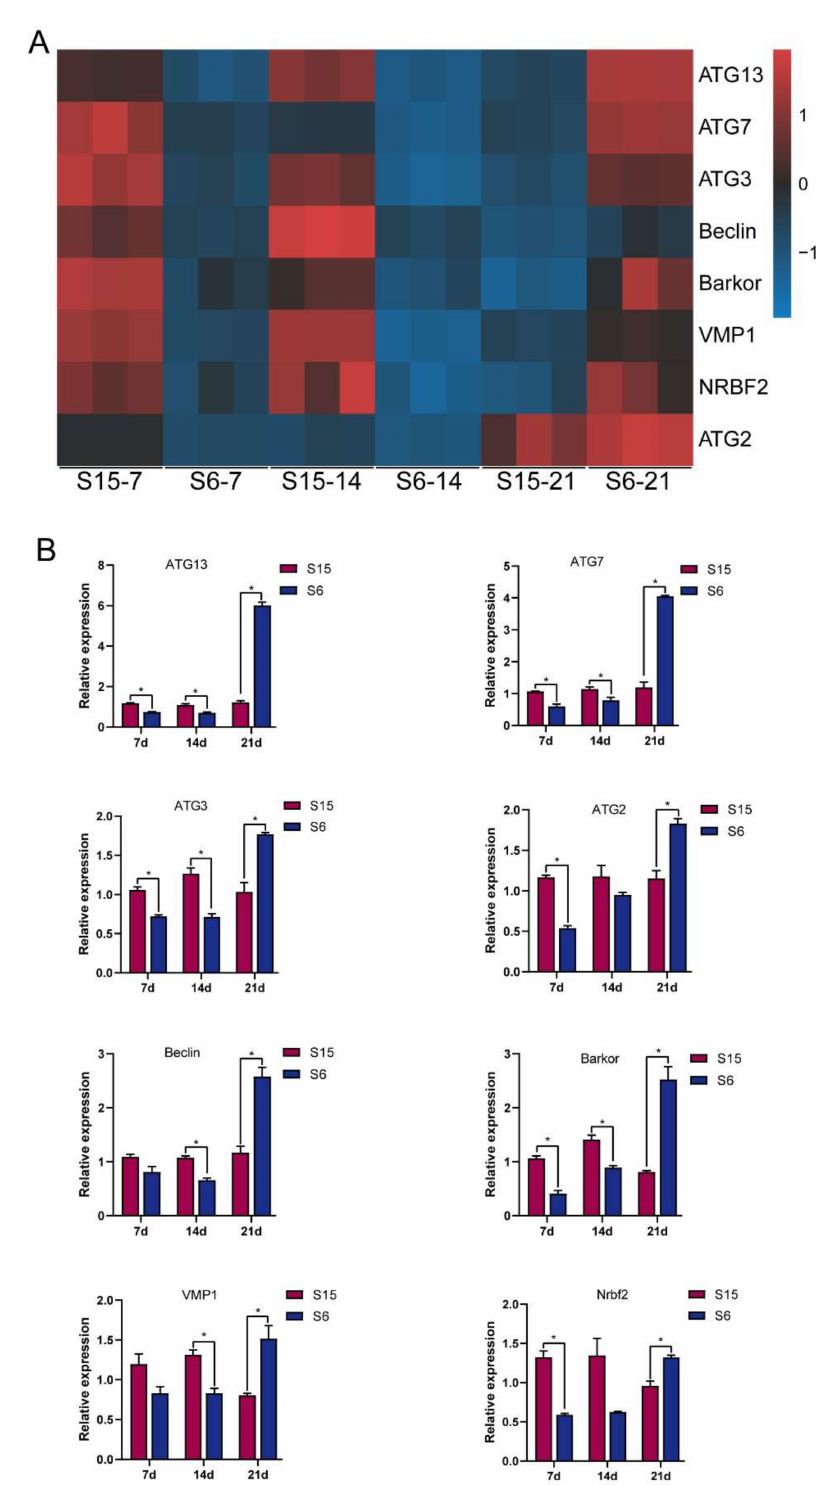
Figure 5. Relative levels of autophagy signaling based on transcriptome analysis and qPCR